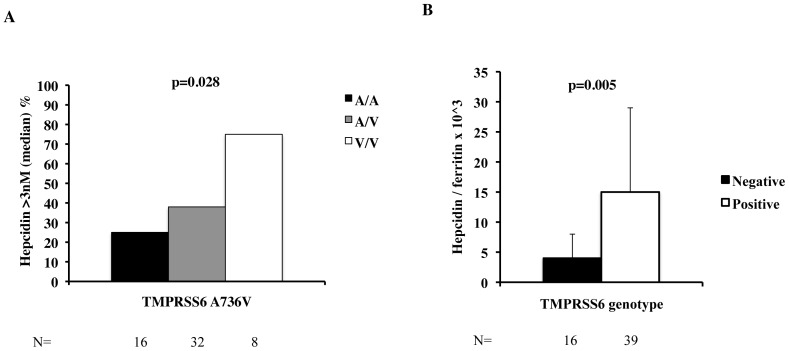
Effect of TMPRSS6 p.A736V genotype on hepcidin levels (hepcidin <3 nM, median value, panel A) and the hepcidin/ferritin ratio (panel B) in 55 patients with NAFLD (25.5% of the whole series).